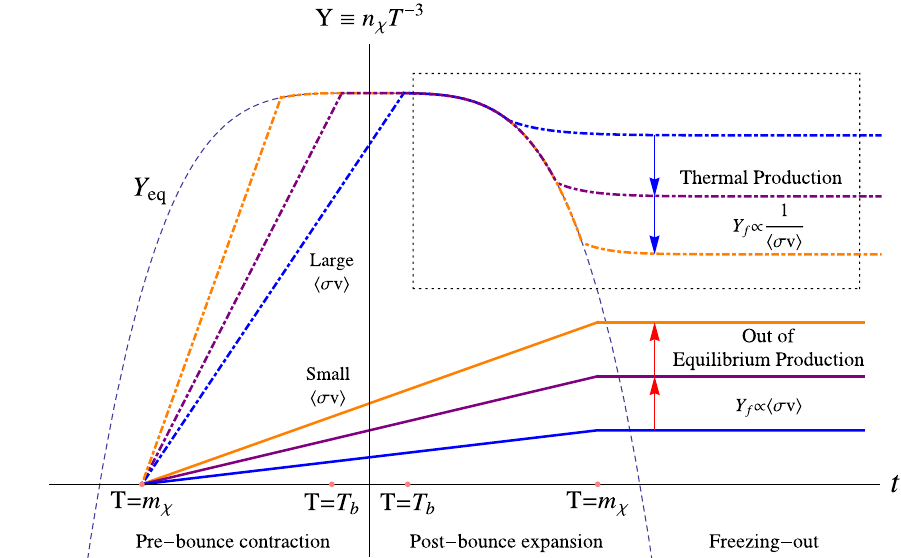
Fig. 2 The dark matter production and evolution in time is plotted. The Y-axis is dark matter number density per entropy. A few characteristic temperatures are indicated on the time axis. When dark matter is produced in plenty abundance to reach the thermal equilibrium envelope, early universe information is washed